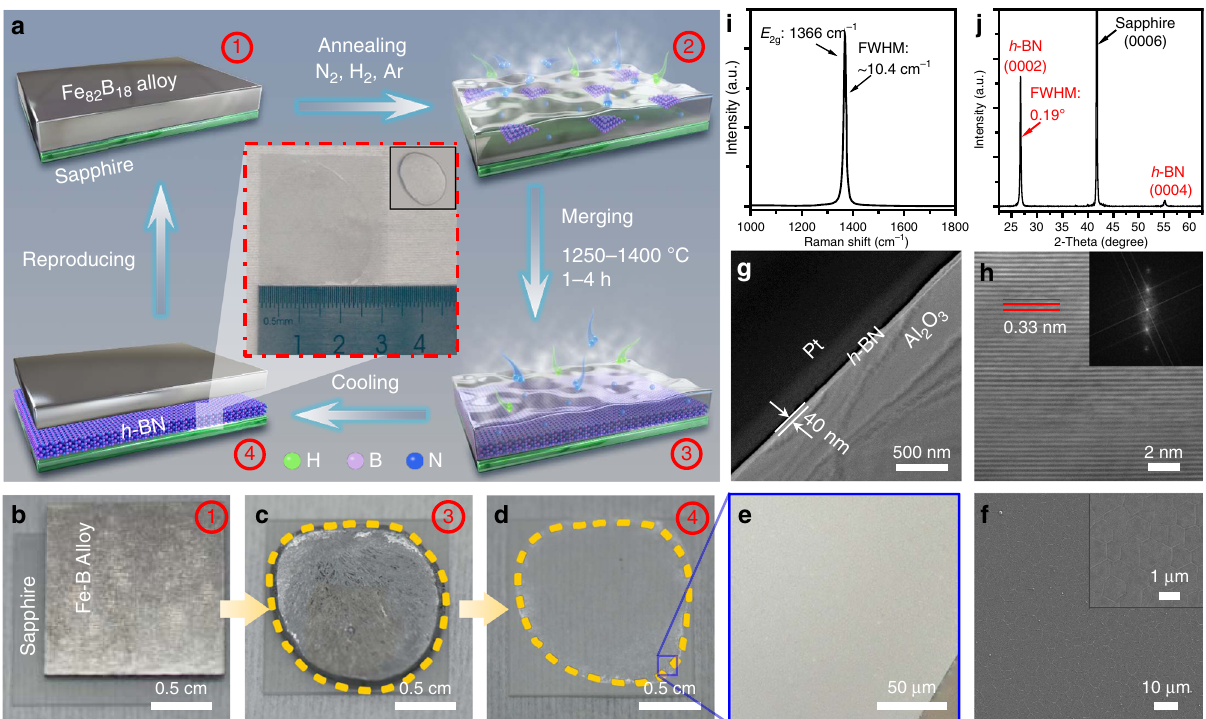
Fig. 1 Fabrication of large-area multilayer h -BN on sapphire. a Schematics of multilayer h -BN grown on sapphire with Fe 82 B 18 alloy and nitrogen as reactants. b – d OM images of Fe – B alloy on sapphire before and after the growth process. e , f OM and SEM images of multilayer h -BN on sapphire. g Cross- sectional TEM image of multilayer h -BN on sapphire. h High-resolution TEM image corresponding to ( g ). The fast Fourier transform (FFT) pattern is displayed in the inset. i , j Typical Raman and XRD spectra of multilayer h -BN fi lm on